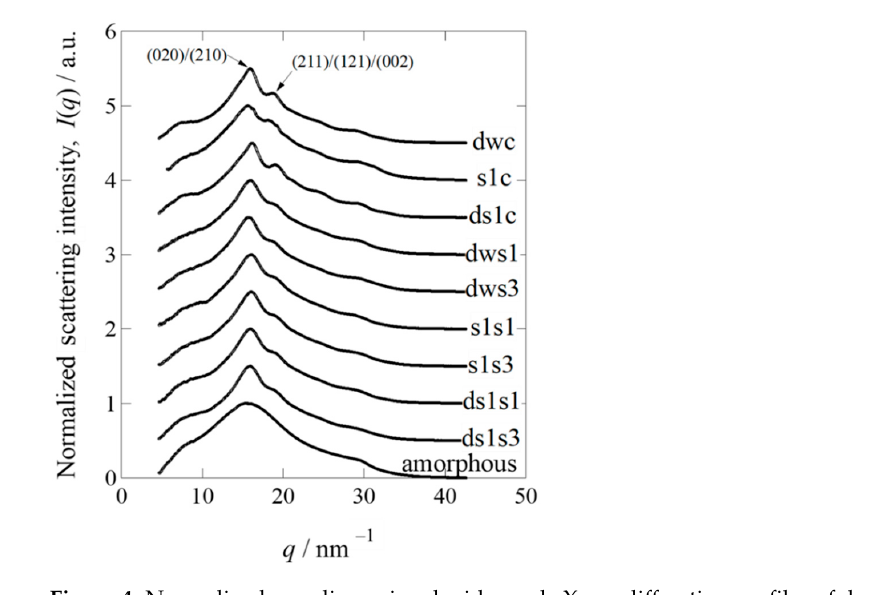
Figure 4. Normalized one-dimensional wide-angle X-ray diffraction profiles of degummed w1-pnd (dwc), Ser1-P1A269 (s1c), and degummed Ser1-P1A269 (ds1c) cocoons, as well as sponges prepared from degummed w1-pnd with 1% (dws1) and 3% (dws3) methanol, Ser1-P1A269 with 1% (s1s1) and 3% (s1s3) methanol, and degummed Ser1-P1A269 with 1% (ds1s1) and 3% (ds1s3) methanol. To avoid overlap, all profiles were vertically shifted at 0.5 intervals, except for the amorphous sample (no vertical shift). Table 1. Wide-angle X-ray diffraction analysis of the cocoons and fibroin sponges. (020)/(210) ** (211)/(121)/(002) Peak Samples Crystallinity Position/nm −